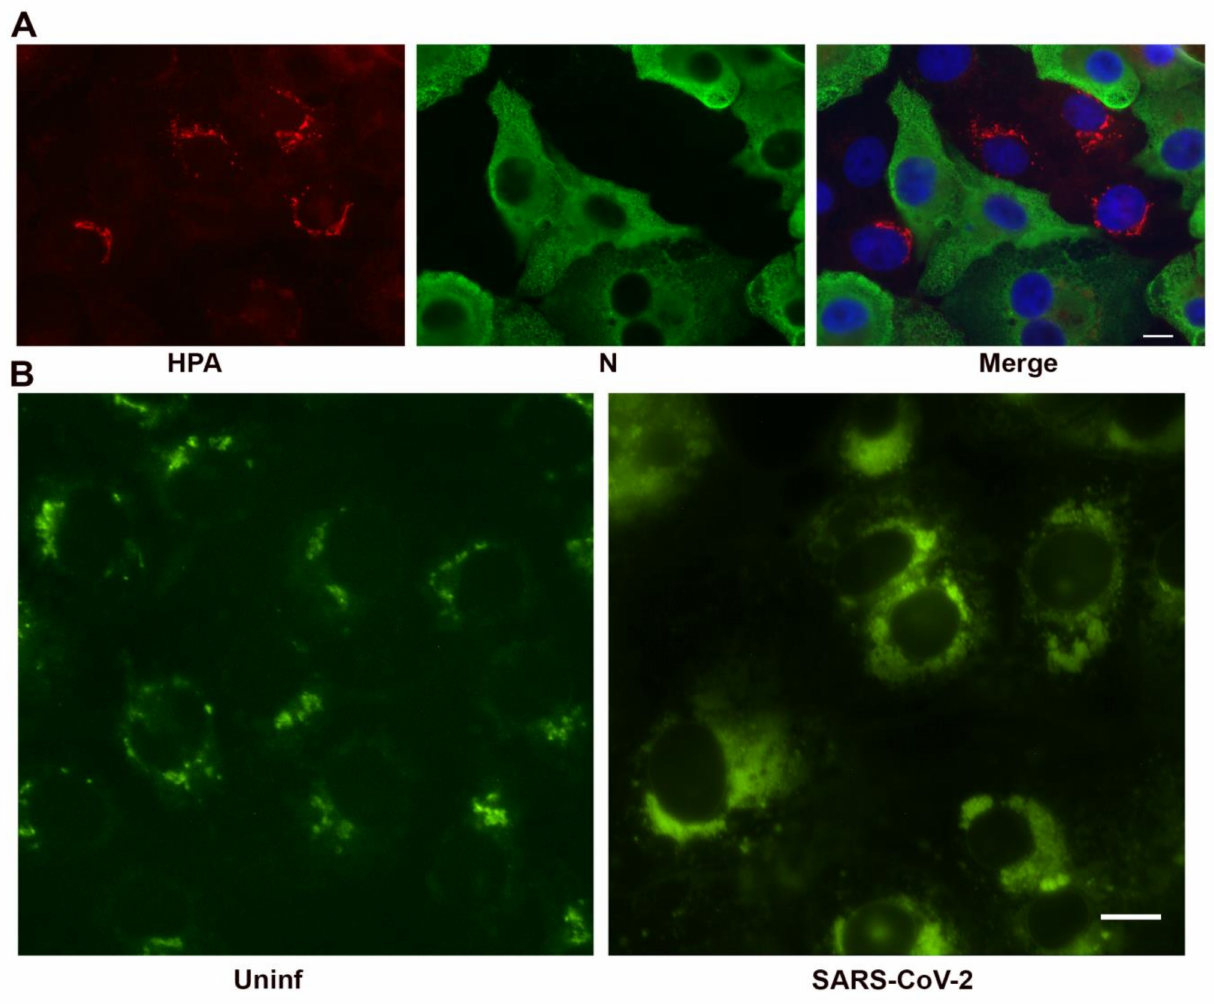
Figure 6. Non-antibody labeling of the Golgi apparatus in infected cells at 24 h post-infection. ( A ) Helix pomatia agglutinin labeling of the Golgi apparatus (red). Infected cells are shown in green and the nucleus in blue in the merged image. ( B ) C 6 -NBD-ceramide labeling of Golgi membrane in glutaraldehyde fixed, infected cells. Bars = 10 µ